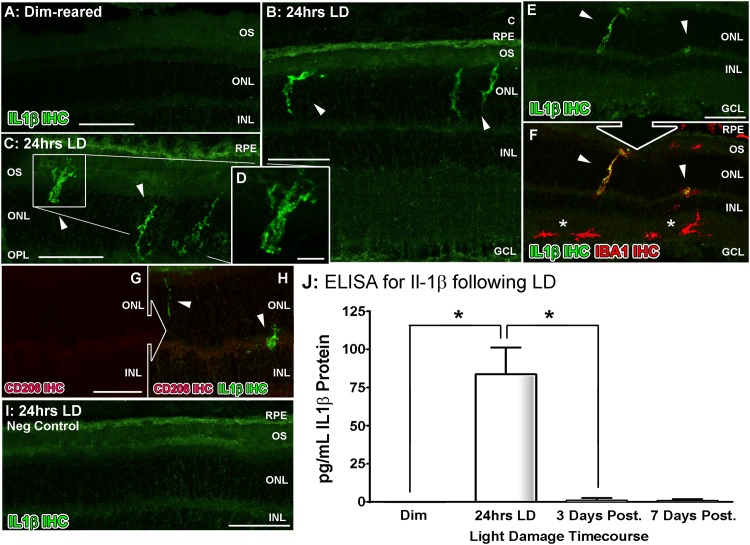
Spatiotemporal analysis of retinal Il-1β protein levels following LD.
A-G: Immunohistochemical assessment of Il-1β expression (green) in retinal cryosections over the course of LD. A: Immunoreactivity (IR) for Il-1β protein was not observed in dim-reared animals. B-D: Il-1β-IR was present among ramified nuclei situated within the ONL and OS (arrowheads) immediately following exposure to 24hrs LD. E-F: Il-1β-IR co-localised with IBA1+ cells (red) situated in the ONL/OS, though was not apparent in IBA1+ cells outside the vicinity of the ONL (asterisks). G-H: Il-1β-expressing cells (H, arrowheads) did not show any discernible IR for the M2 marker CD206 (red). I: Negative control sections, in which the primary antibody was omitted, did not show any resemblance to the IR for Il-1β evidenced in C-D at 24hrs LD. J: ELISA for Il-1β protein indicated an increased abundance of the protein immediately after 24hrs LD (P<0.05), and which was virtually undetectable at all other time points. C, choroid; GCL, ganglion cell layer; INL, inner nuclear layer; IHC, immunohistochemistry; ONL, outer nuclear layer; OS, outer segments; RPE, retinal pigment epithelium. The trend in ELISA protein levels was significant by ANOVA (P < 0.05); N = 3 for each timepoint.